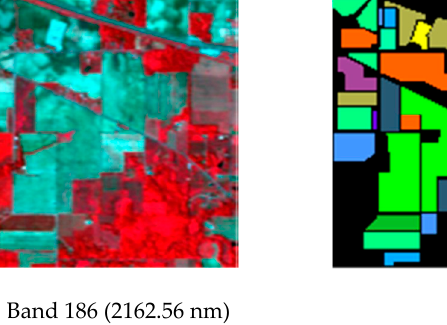
Figure A2. Purdue’s Indiana Indian Pines scene.